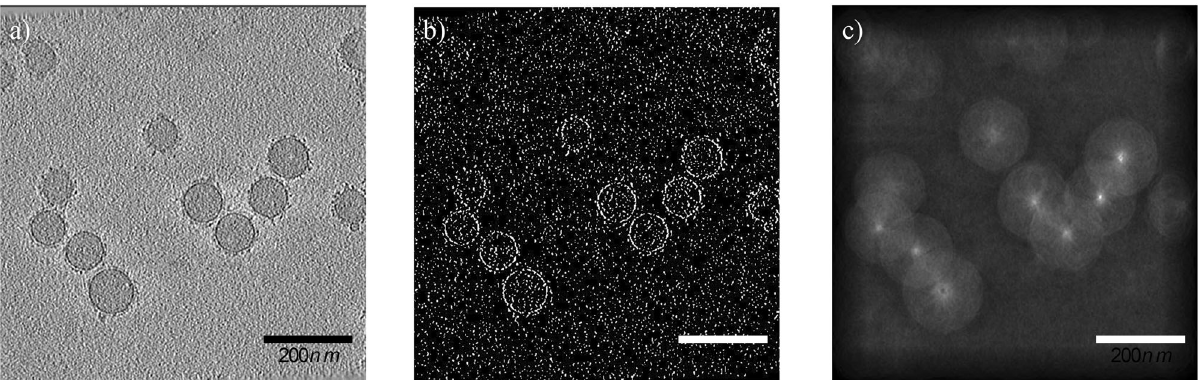
Fig. 8 Representative example of applying the thresholds, as de fi ned in Fig. 7. a The 42nd raw slice of the low-concentration sample. b The slice after implementing the optimum binarization threshold. c The center of the NPs, as detected via the Hough transformation, extended to 3D spherical shells.